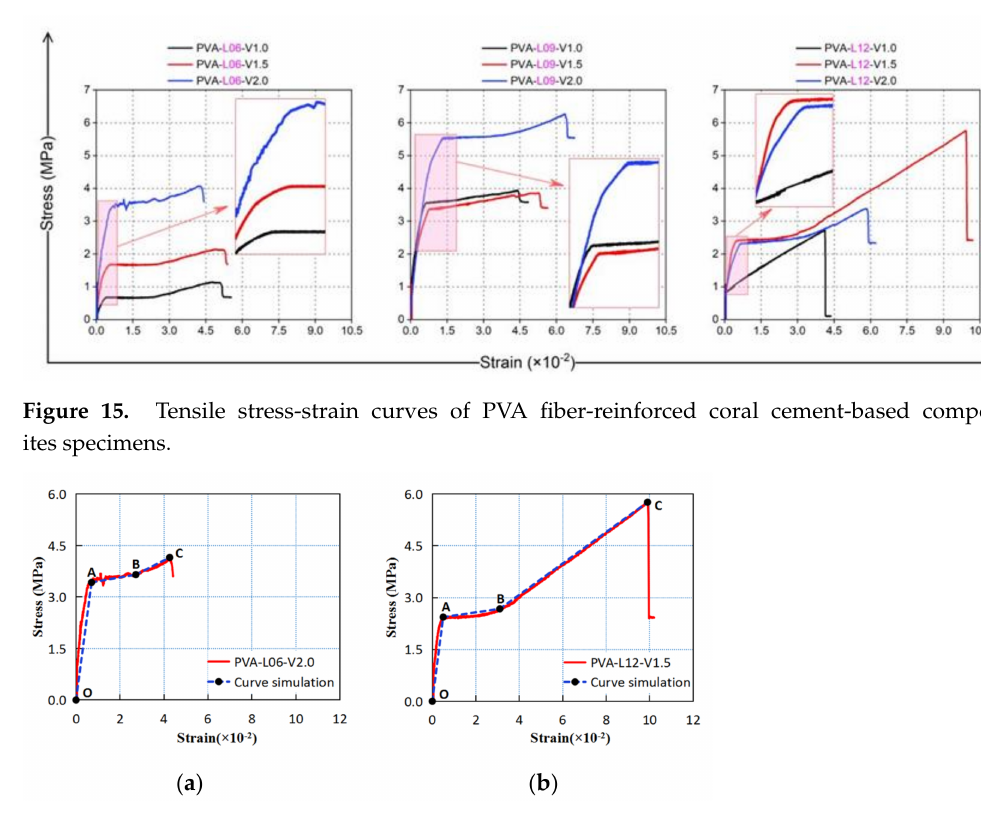
Figure 16. Comparison of the tensile stress-strain curves with the trilinear constitutive model